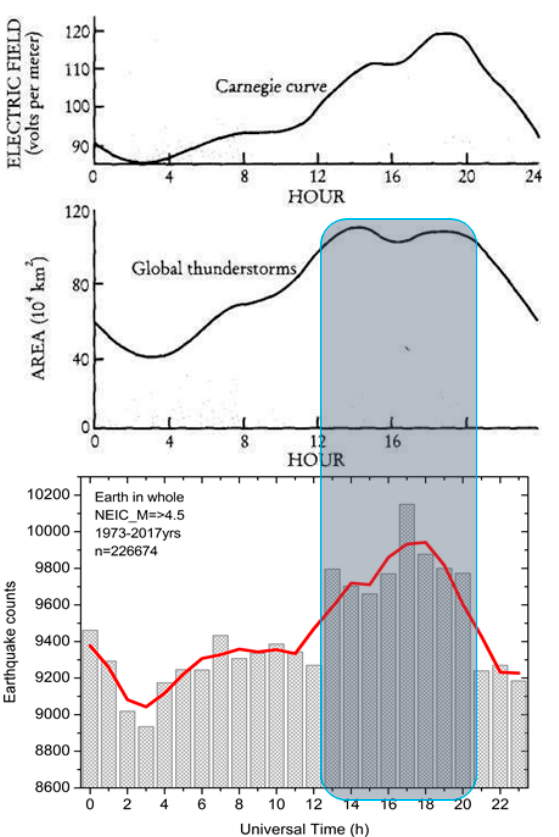
Figure 15. From top to bottom: Carnegie curve and global thunderstorm activity (after Whipple and Scrase, 1936) [40], and global seismic activity UT distributions.